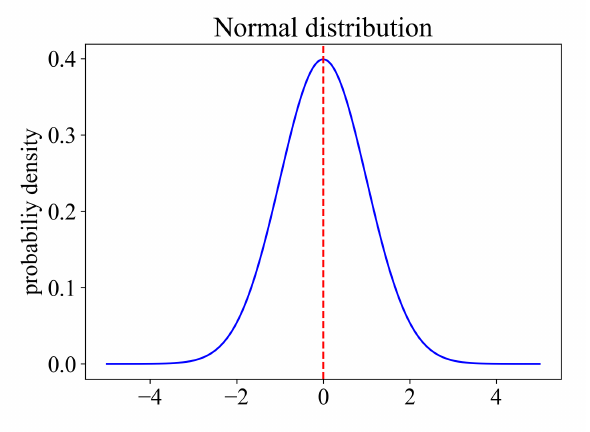
Figure 3. The probability density function of Gaussian distribution N ( 0,2 ) .